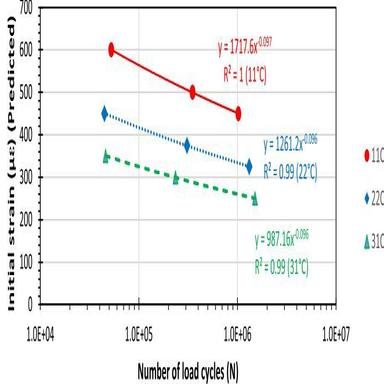
Predicted strain-controlled fatigue curves for different temperatures using SPARK Model-2a .